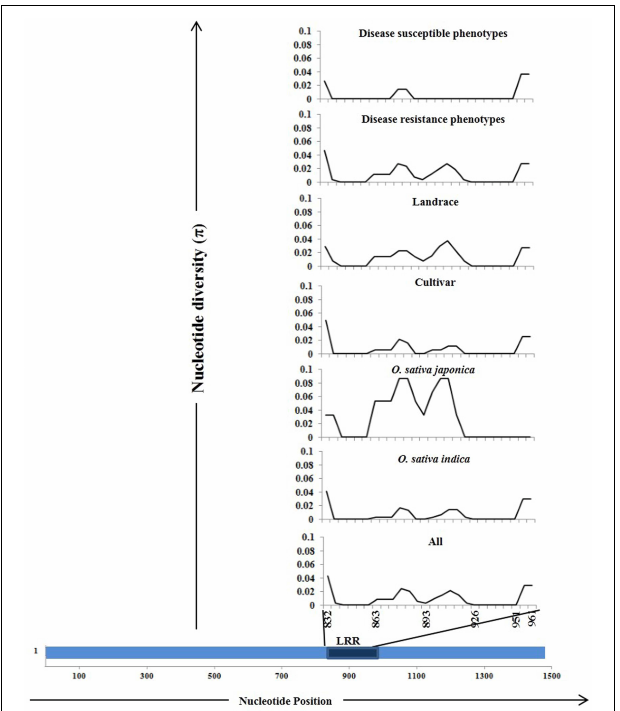
FIGURE 3 | Sliding window analysis of nucleotide diversity ( π ) in the LRR domains of 92 Pi54 alleles. The different groups from where the alleles were mined are given above in the Figure. The nucleotide diversity ( π ) was plotted on Y-axis and the X-axis represents the positions of nucleotides.